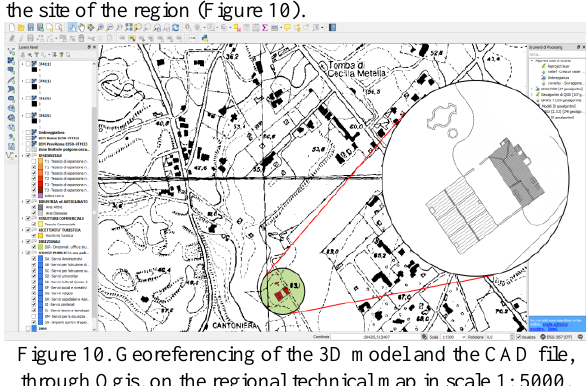
Figure 10. Georeferencing of the 3D model and the CAD file, through Qgis, on the regional technical map in scale 1: